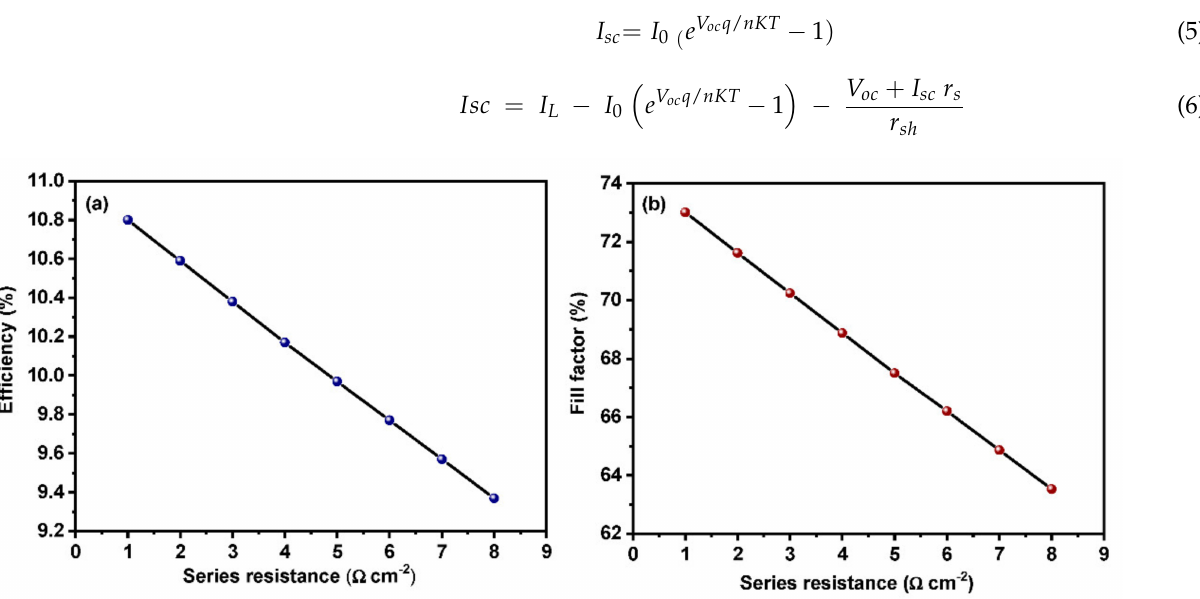
Figure 8. Effect of series resistance on ( a ) efficiency and ( b ) fill